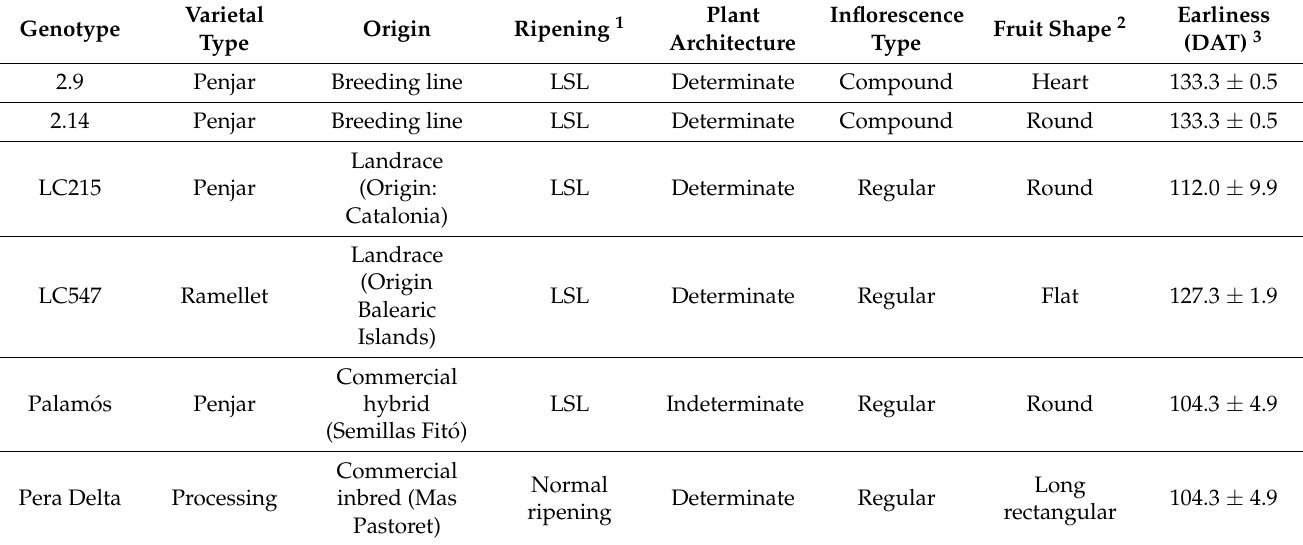
Table 1. Description of plant